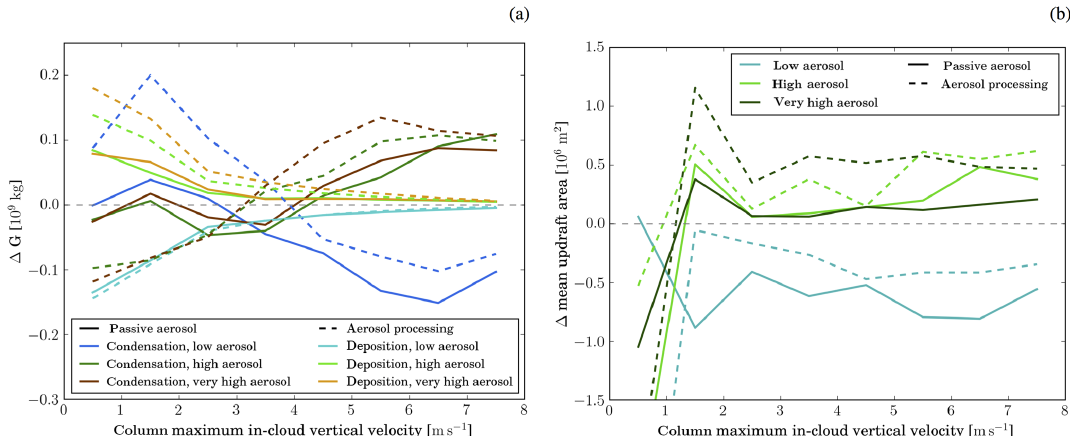
Figure 9. Changes in (a) condensate gain and (b) updraft area for updraft regions with different column maximum in-cloud vertical velocities. In (a) dark colours represent changes in condensation and lighter colours changes in deposition relative to the simulation with the standard- aerosol profile. Solid lines correspond to simulations with passive aerosol and dashed lines to simulations with aerosol